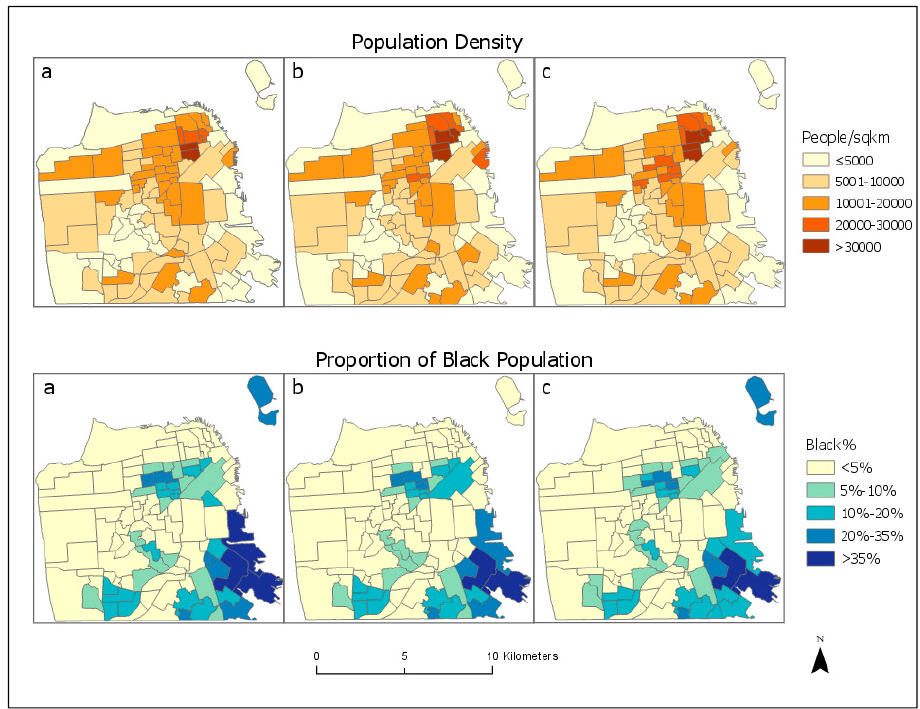
Figure 3. Areal interpolation using three methods: ( a ) areal interpolation, ( b ) residential proportion, and ( c ) parcel and decennial census data as ancillary information.